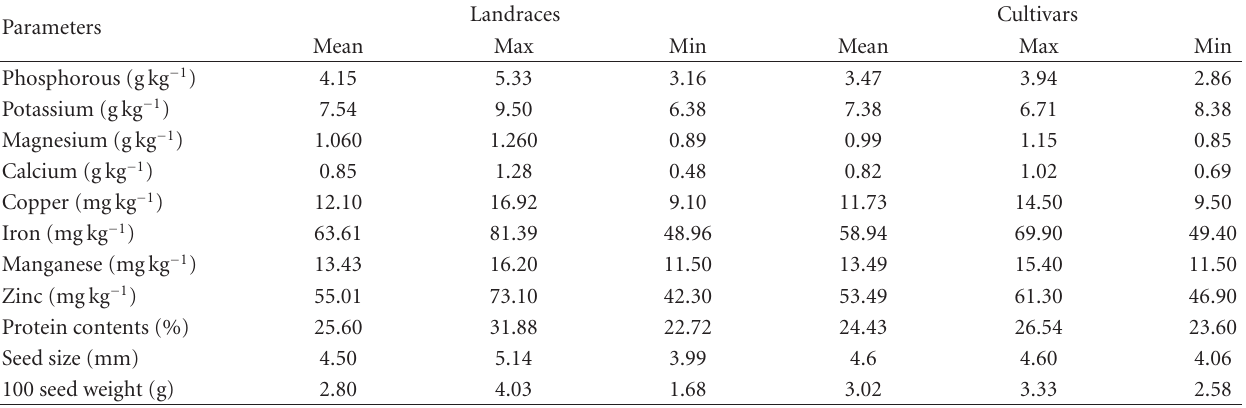
Table 1: Mean and range variation of mineral elements and other traits of Turkish lentil landraces and cultivars.